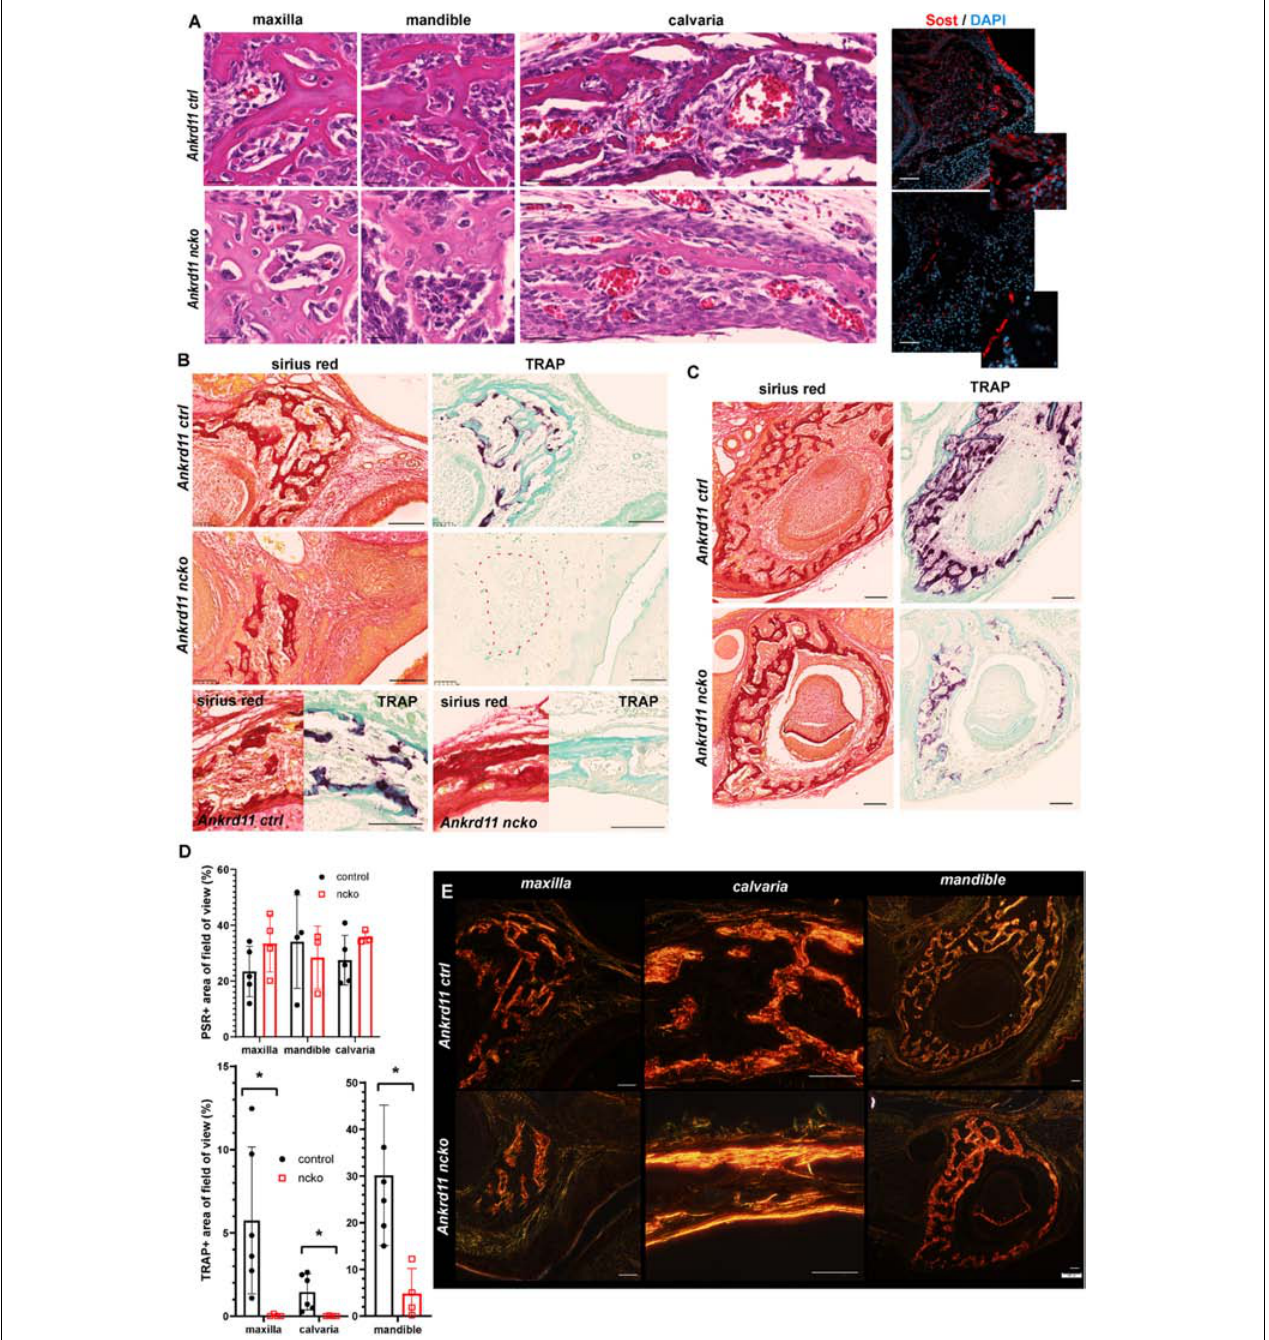
FIGURE 8 | Bone maturation is delayed in Ankrd11 ncko mice. (A) Representative sections of maxillary, mandibular, and calvarial bone from Ankrd11 ctrl (top row) and Ankrd11 ncko (bottom row) mice at P0. Sections were stained simultaneously for H&E to reveal cell morphology and bone organization. Images were taken at anatomically matching locations. Images in right column depict sections immunostained for sclerostin (Sost, red) in the P0 maxillary bone, demonstrating a reduction in Sost + cells in Ankrd11 ncko maxillary bone. DAPI (blue) was used to counterstain nuclei. Scale bars in first two columns represent 25 µ m, and last two represent 50 µ m. (B) Sirius red and tartrate-resistant acid phosphatase (TRAP) staining of maxilla and calvaria of Ankrd11 ctrl and Ankrd11 ncko mice at P0 on neighboring sections. Red dotted line outlines region of bone in Ankrd11 ncko maxilla with no TRAP-positive cells, indicating a reduction in remodeling. Calvarial images are taken at the same point midway between the eye and fontanelle. Scale bars represent 100 µ m. (C) Sirius red and TRAP staining of the mandible in Ankrd11 ctrl and Ankrd11 ncko mice at P0 showing a decrease in TRAP-positive cells in the mandibular bone. Scale bars represent 100 µ m. (D) Quantification of images shown in (B,C) (independent two-sample T -test assuming unequal variances, * p < 0.05, n = 5). (E) Polarized light images of sirius red stained maxilla, calvaria, and mandible in control and Ankrd11 ncko mice at P0 showing differences in extent of collagen fibril interconnection and orientation. Scale bars represent 50 µ m.